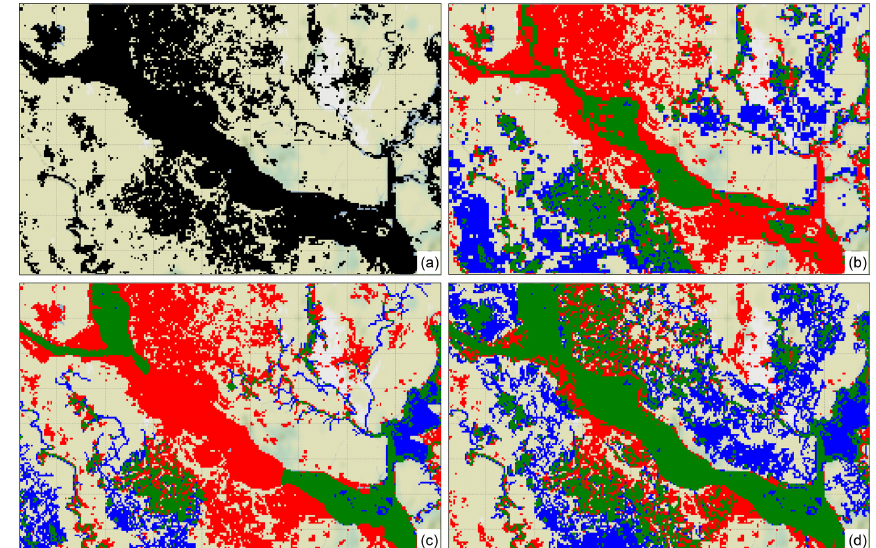
Figure 7. (a) Observed flood extent by MODIS; overlay of observed and modelled flood extent for (b) downscaled PCR, (c) downscaled PCR → CMF, and (d) PCR → CMF → LFP where blue indicates model only, red indicates observation only, and green indicates agreement between model and